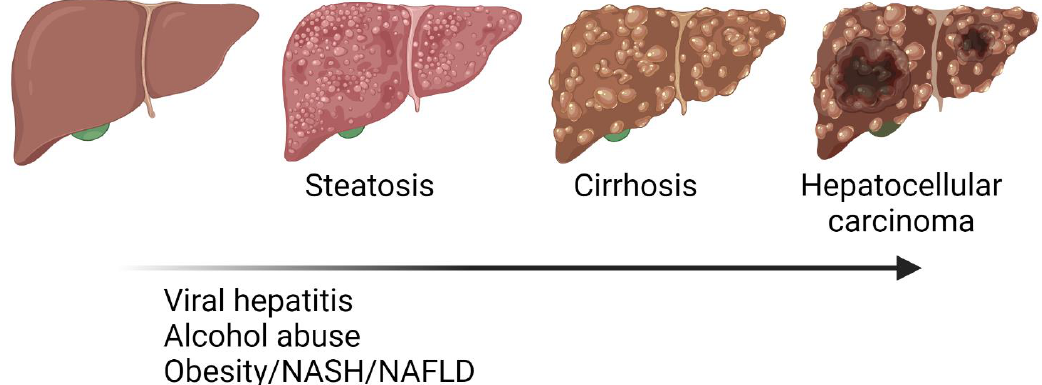
Figure 1. Progression from steatosis, fibrosis, cirrhosis to hepatocellular carcinoma (HCC). Liver diseases involve different pathological events including metabolic reprograming, inflammation, extracellular matrix imbalance, functional impairment, and cellular transformation. Major risk factors for liver diseases are already known but pathogenic mechanisms must still be elucidated to improve their clinical management.